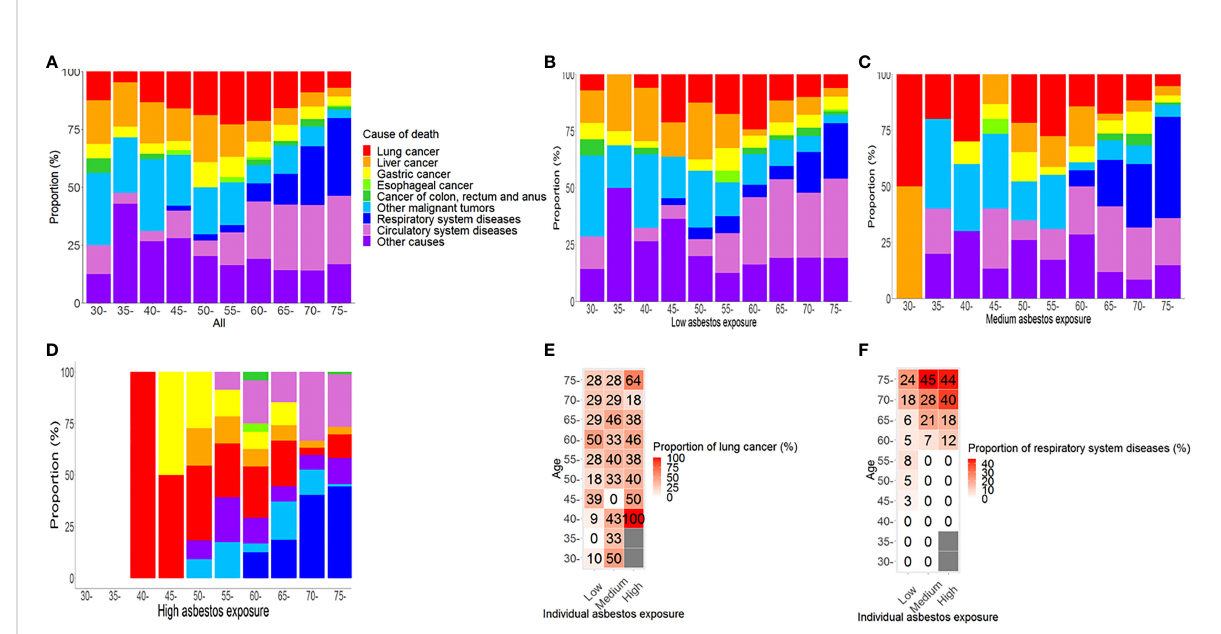
FIGURE 3 Causes of death by asbestos exposure level and age group among females. (A) Proportions of causes of death in all females; (B) Proportions of causes of death among females with low asbestos exposure; (C) Proportions of causes of death among females with medium asbestos exposure; (D) Proportions of causes of death among females with high asbestos exposure; (E) Proportion of individuals who died from lung cancer in subgroups of each cross table among females; (F) Proportion of individuals who died from respiratory system disease in subgroups of each cross table among